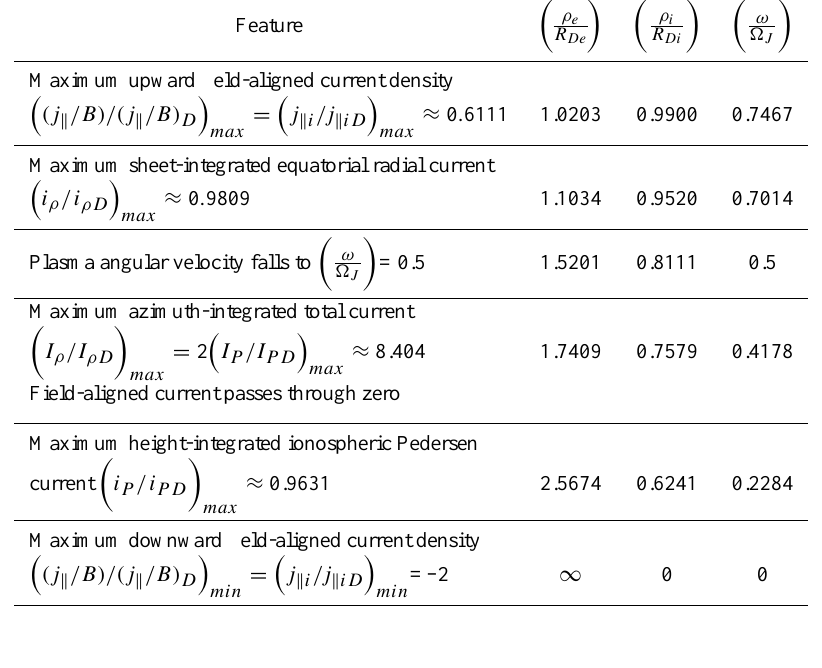
(cid:18) ρ e R De